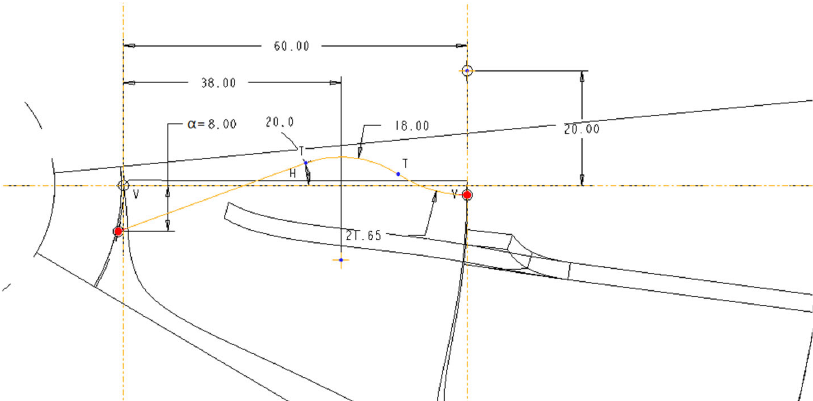
Figure 3. Design size of type A.